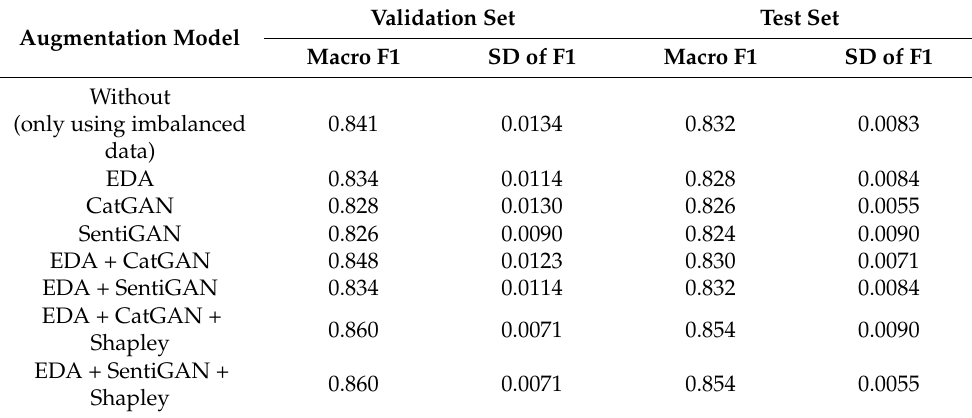
Table 6. Classification performance based on Macro F1 and F1 standard deviation (SD) in five-fold cross